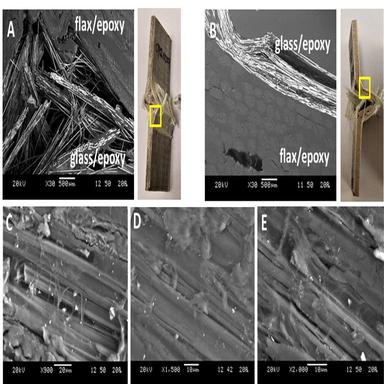
Fatigue failure mechanisms. (A) Type A configuration showing SEM image and photograph of the plate with a yellow square where SEM was taken, (B) Type B configuration showing SEM image and photograph of the plate with a yellow square where SEM was taken, (C) SEM image of Type A flax/epoxy ply at 900× magnification, (D) SEM image of Type A flax/epoxy ply at 1500× magnification, and (E) SEM image of Type A: flax/epoxy ply at 2000× magnification. (For interpretation of the references to color in this figure le